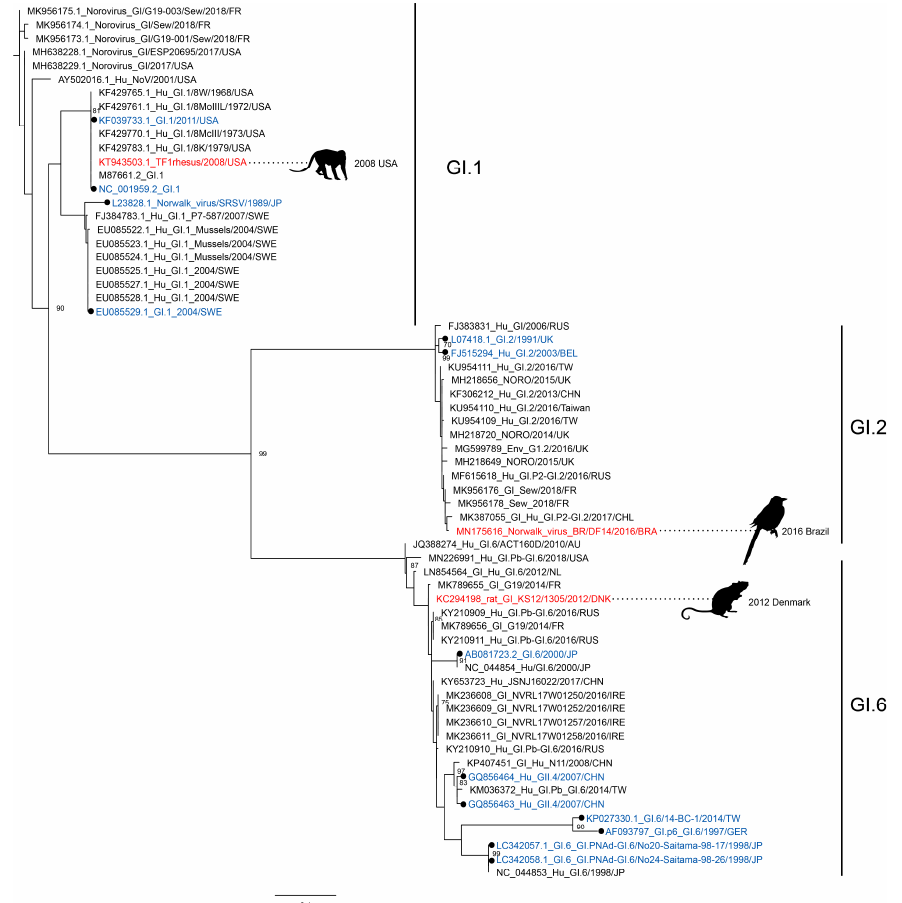
Figure 2. Genetic characterization of non-GII.4 GII sequences found in animals. A maximum- likelihood tree based on 180 bp GII sequences was inferred with PhyML v3.0 software using the general time reversible nucleotide substitution model (GTR + G). Sequences that were found in animals (red) were aligned with most closely related human sequences (black) and the reference sequences from the noronet typing tool (blue, black circle). The animal in which norovirus was found as well as the date and country of collection are indicated next to the sequence. The scale bar indicates nucleotide substitutions per site.